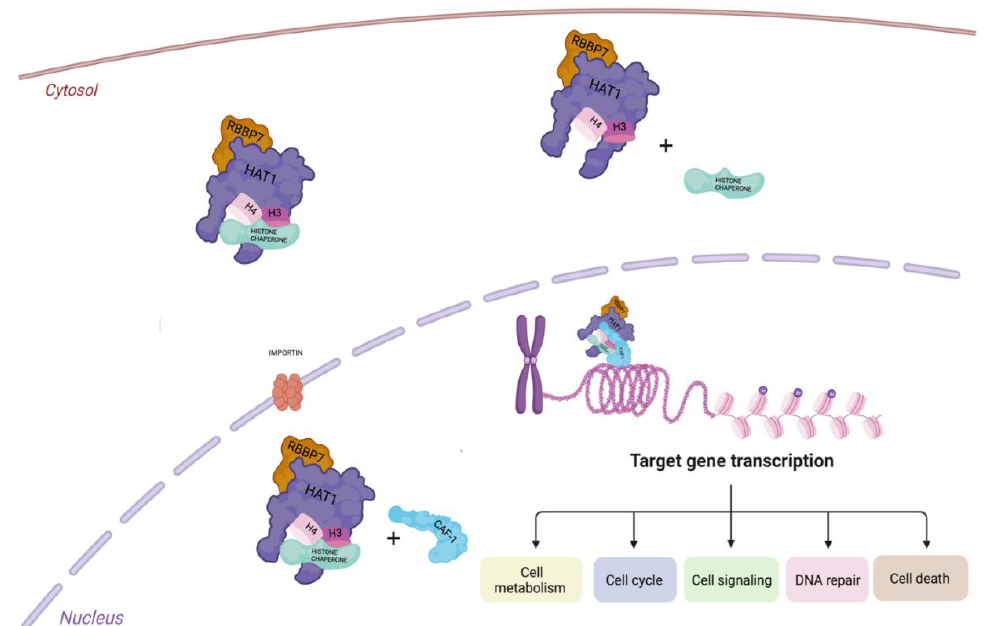
Figure 1. Graphical illustration of HAT1 function. ( A ) Interaction of the Hat1/Rbap46 complex with histones in the cytoplasm and subsequent transfer into the nucleus via importin, binding histone chaperone protein. ( B ) Once inside the nucleus, HAT1 interacts with CAF1 and facilitates the path- way for deposition of newly synthesized histones to regulate gene transcription.